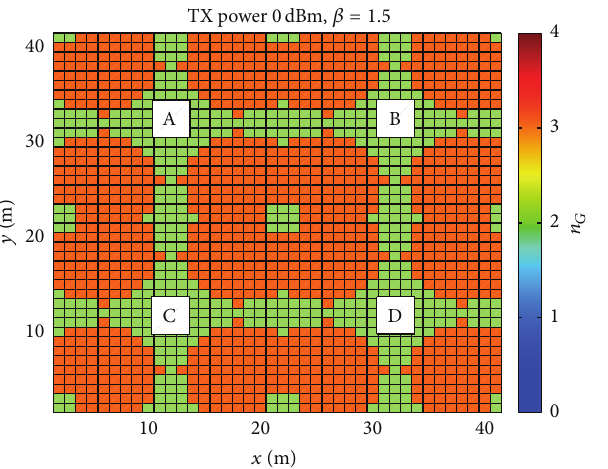
Figure 9: Performance of 4 × 4 i-MIMO DAS in a 2D deployment case. Relative gain with respect to SISO is shown (RAU antenna power: 0dBm; 𝛽 = 1.5; RAU antenna distance: 20 m).